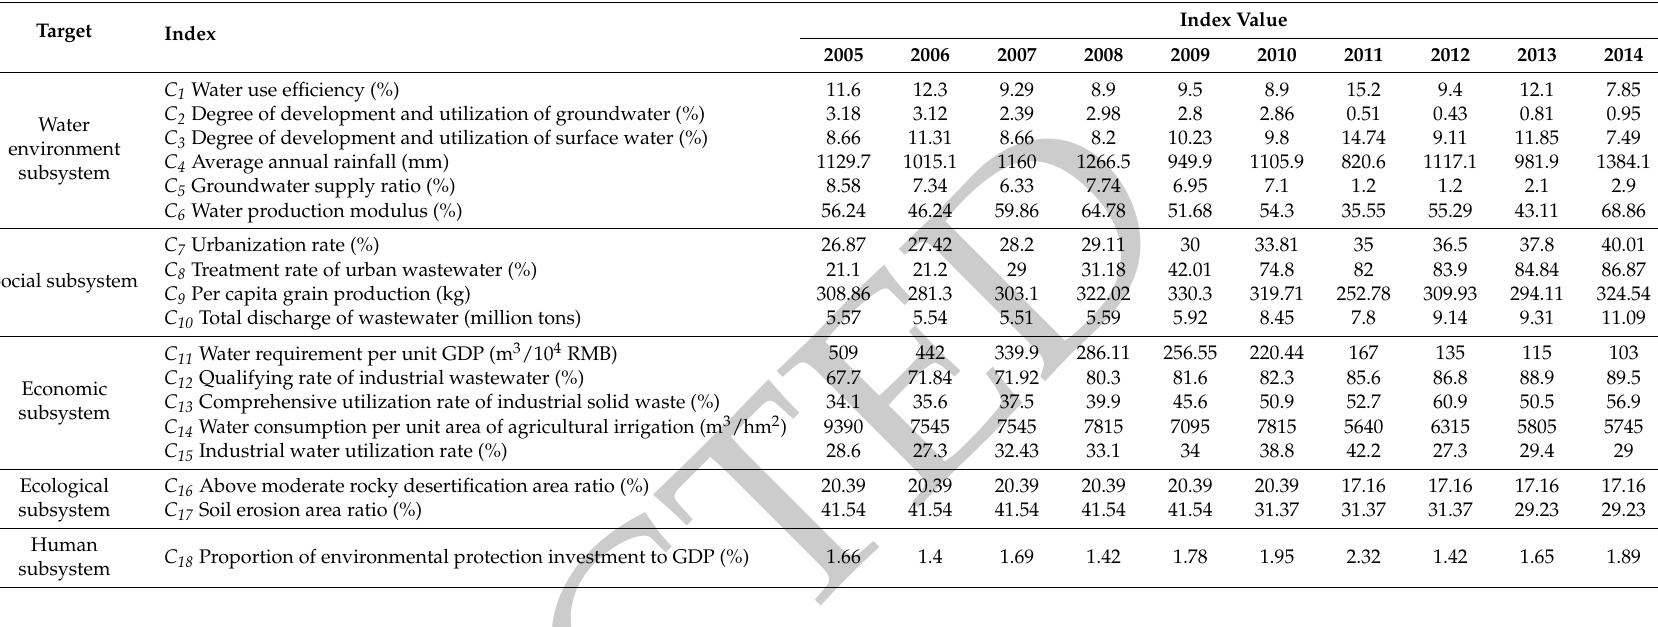
Table 4. Data of water resource security evaluation index in karst area, Guizhou